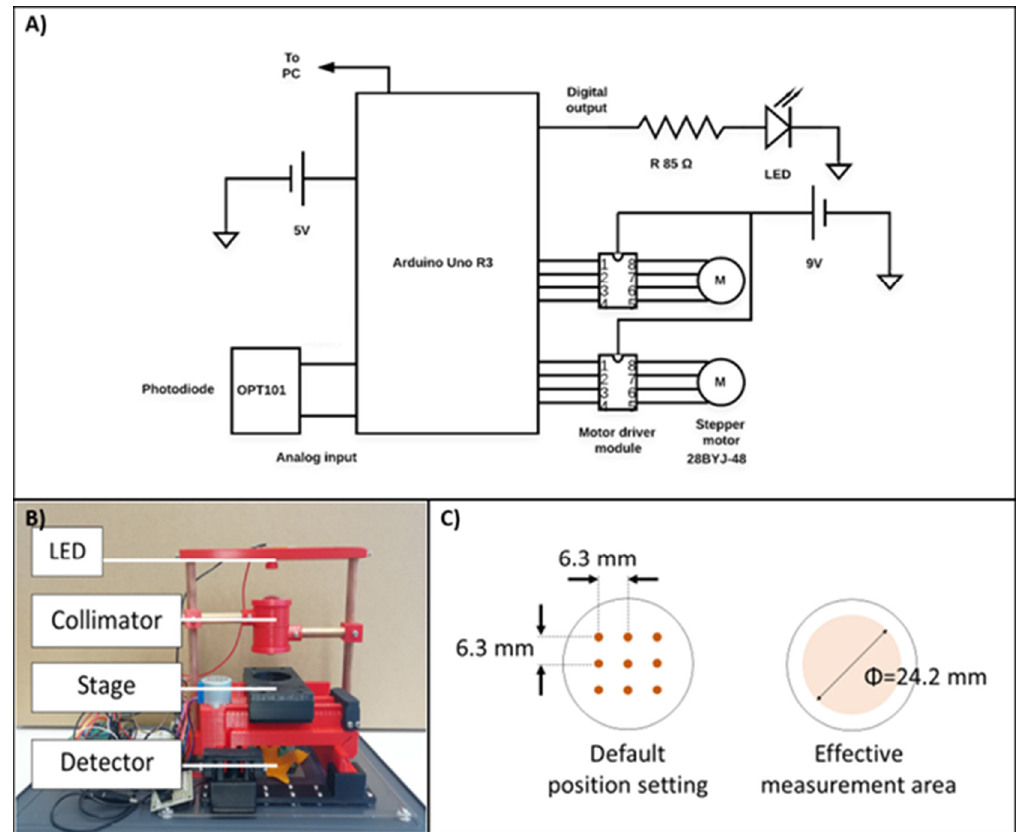
Figure 1. ( A ) Schematic electronic diagram of the measuring unit (OPT101: monolithic photodiode; Arduino Uno R3: microcontroller). ( B ) Picture of the semi-automatic system, with the major parts of the device: LED, Collimator, Stage, and photodiode detector, as mentioned in the materials and methods). ( C ) Position of the 9 spots over the 35 mm cell culture dish diameter, where the transmittance is measured.